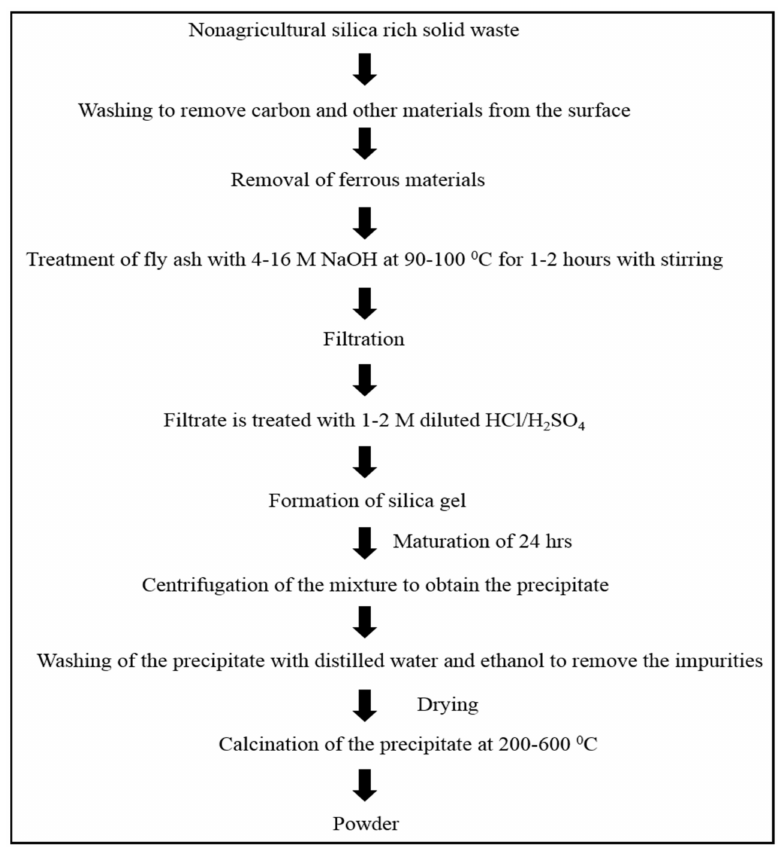
Figure 2. Schematic diagram of the synthesis of silica from silica-rich waste materials.